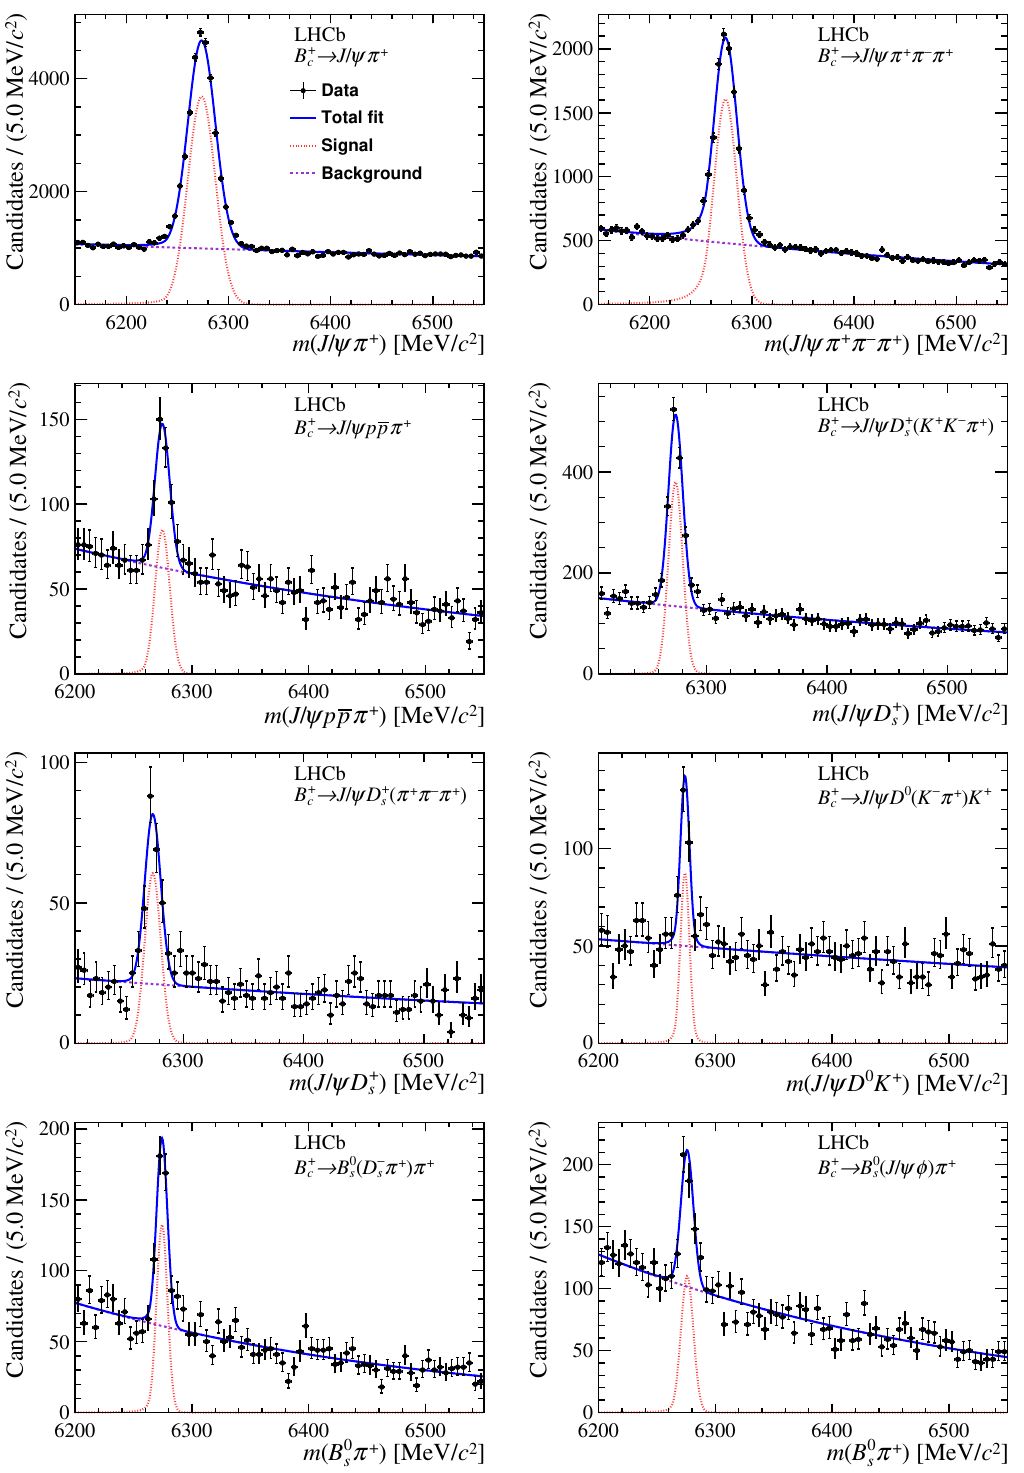
Figure 1. Distributions of invariant-mass m for B + candidates selected in the studied decay chan- c nels, where data are shown as the points with error bars; the total (cid:12)ts are shown as solid blue curves; the signal component are red dotted curves; the background components purple dotted